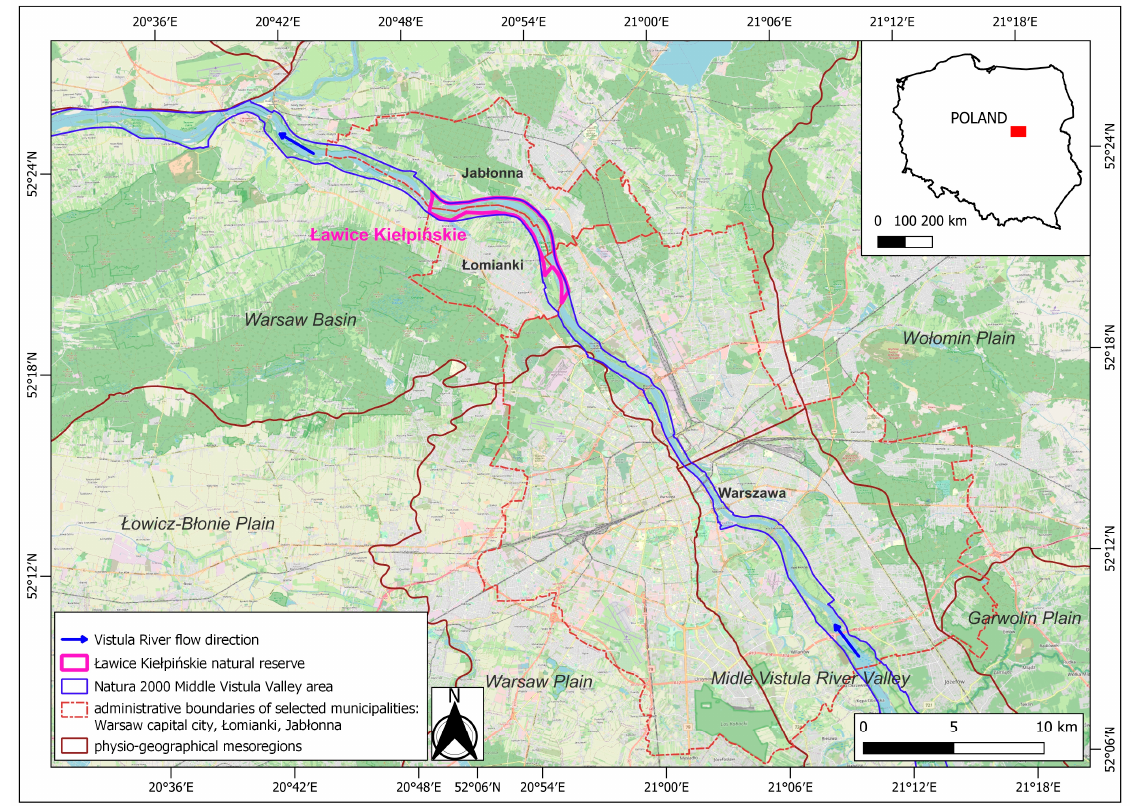
Figure 1. Location of the “ Ł awice Kie ł pi ń skie” natural reserve in the context of Warsaw urban agglomeration. Background map: OpenStreetMap. Data sources: EEA/GDO Ś , GUGiK, Solon et al., 2018 [38], own elaboration.